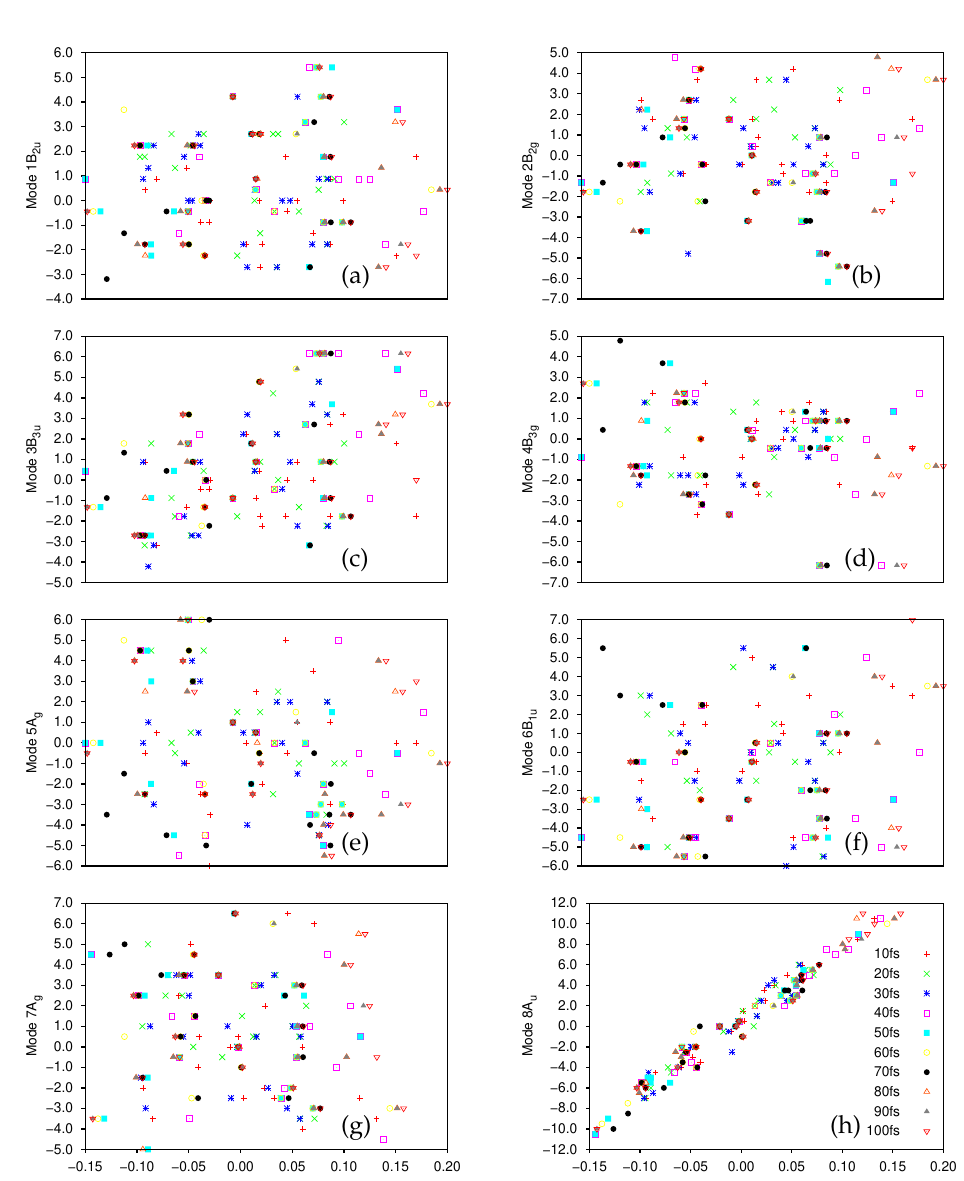
Figure 5. Normal mode coordinates of ethene, sampled on the ground, diabatic electronic state, plotted as functions of the diffusion coordinate: ( a ) Mode 1B 2 u ; ( b ) Mode 2B 2 g ; ( c ) Mode 3B 3 u ; ( d ) Mode 4B 3 g ; ( e ) Mode 5A g ; ( f ) Mode 6B 1 u ; ( g ) Mode 7A g ; ( h ) Mode 8A u . In all cases data points are coloured according to the sample time; 20 gridpoints were sampled every 10fs during the dynamics, the first sampling being after 10fs. Key within plot ( h ) applies to all other